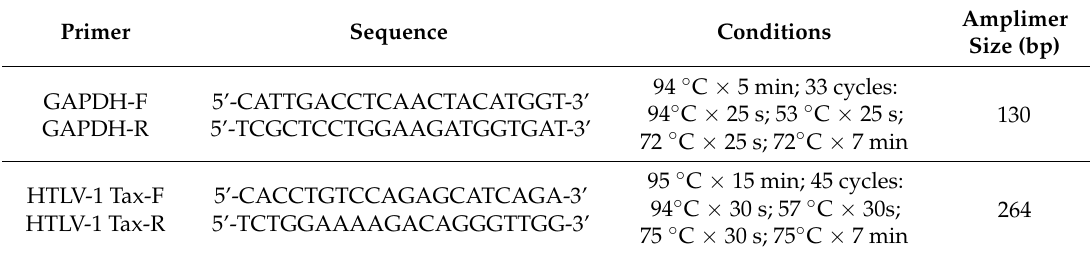
Table 1. Primers and PCR conditions